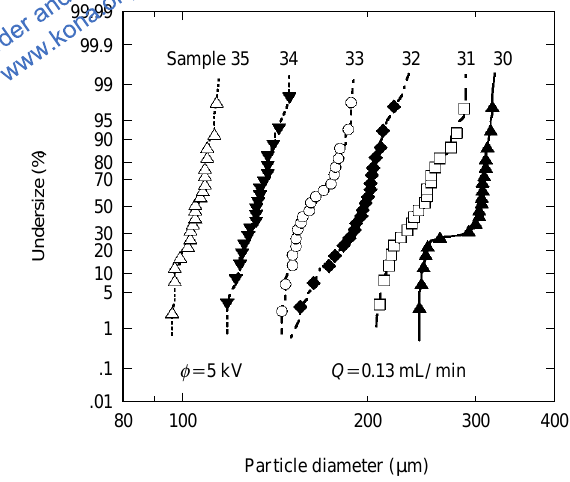
Fig. 8 Particle Size Distributions of Various Samples Applied voltage was 5 kV and flow rate was 0.13 ml/min.